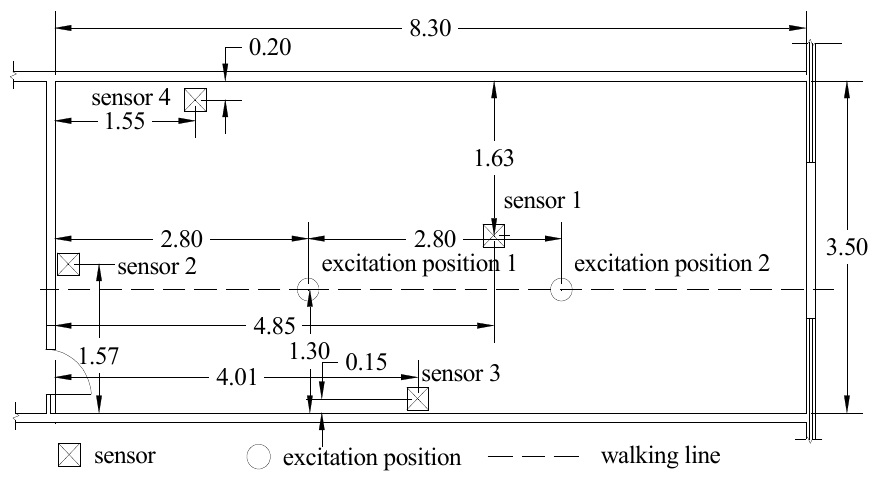
Figure 3. Sensor and excitation position arrangement in experiment (unit: m).